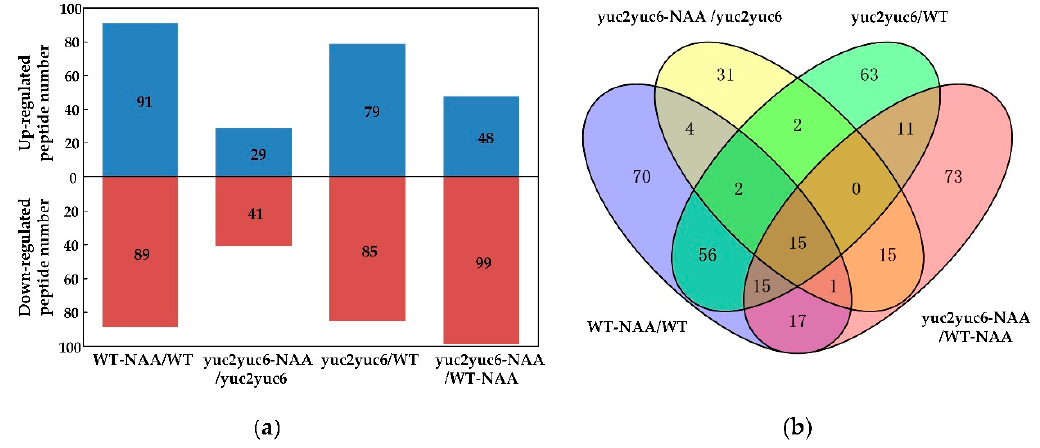
Figure 5. The difference analysis of identified potential SSPs. ( a ) Number of potential SSPs with significant changes. ( b ) Venn diagram of changed potential SSPs among different combinations. WT: wild type.